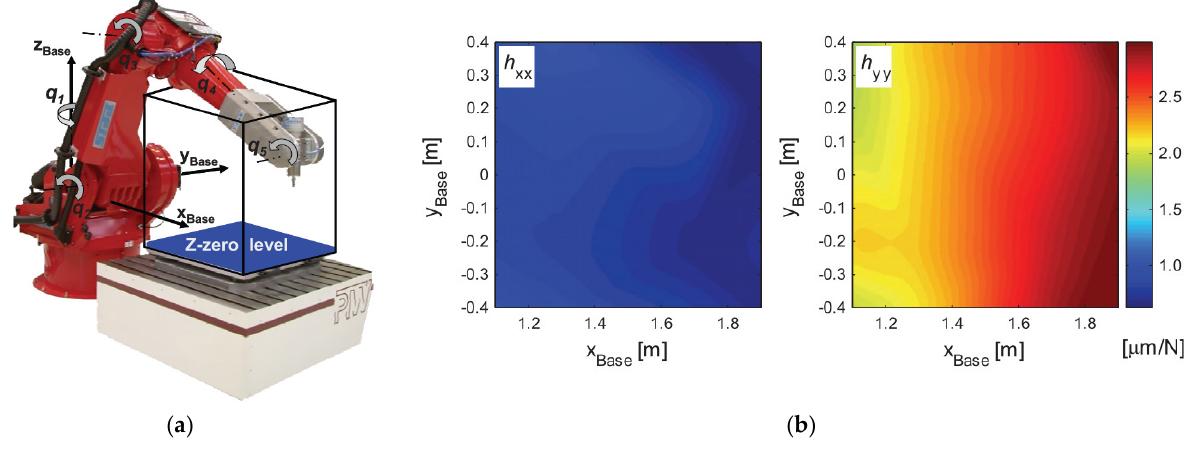
Figure 8. Experimental setup and result [102]: ( a ) Focused work space and Z−level. ( b ) Experimental direct−compliance h xx in the X−direction and h yy in the Y−direction.